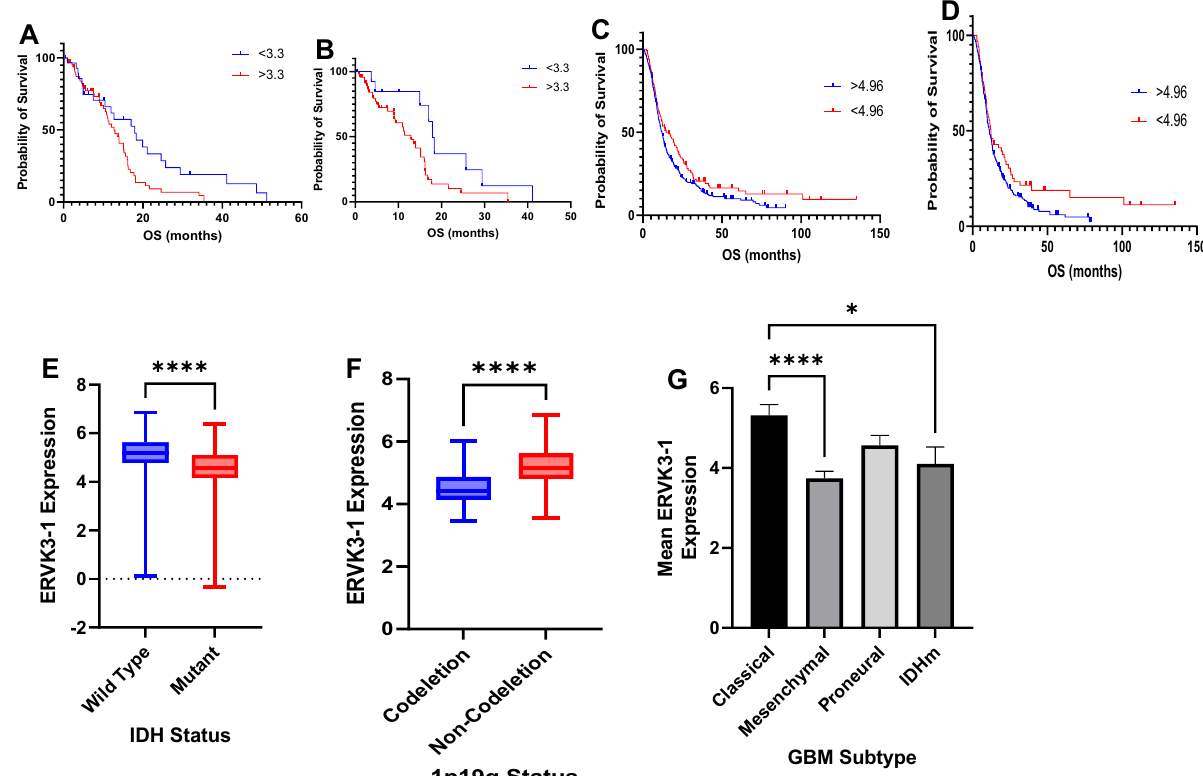
Figure 5. Integrated analyses from The Cancer Genome Atlas demonstrate that HML-6 envelope transcript, ERVK3-1, is a negative prognosticator in glioblastoma patients. ( A ) Across all samples, GBM patients with elevated ERVK3-1 expression had significantly lower median overall survival (17.9 months vs. 12.7 months, p = 0.018). ( B ) IDH-wild-type GBM patients with increased ERVK3-1 expression (> 3.3 FPKM) have a worse OS (17.9 vs. 12.9 months, p = 0.028). Analysis of CGGA data demonstrated significantly lower overall survival in patients with elevated ERVK3-1 expression, in all patients (median OS = 10 months vs. 19.4 months, p = 0.018) ( C) . Among IDHwt patients alone, a similar trend was seen, though these differences were non-significant (median OS = 12.2 months vs. 11.3 months, p = 0.055) ( D ). In addition, patients with IDH mutant GBM had significantly lower ERVK3-1 expression relative to patients with IDHwt tumors (4.57 fpkm vs. 5.19 fpkm, p < 0.0001) ( E ), as did patients with 1p19q co-deletion (4.41 fpkm vs. 5.17 fpkm, p < 0.0001) ( F ). ( G ) Analysis of ERVK3-1 expression by GBM subtype revealed that the classical subtype has significantly higher ERVK3-1 expression than both mesenchymal glioblastomas and IDHm